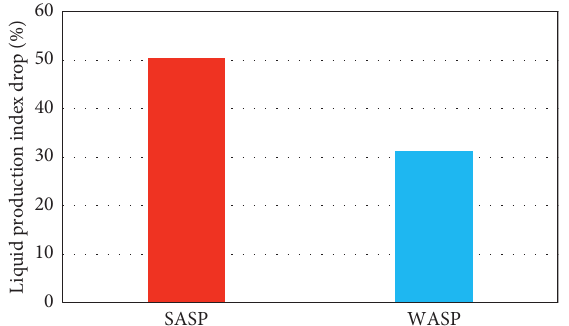
Figure 15: Fluid production index